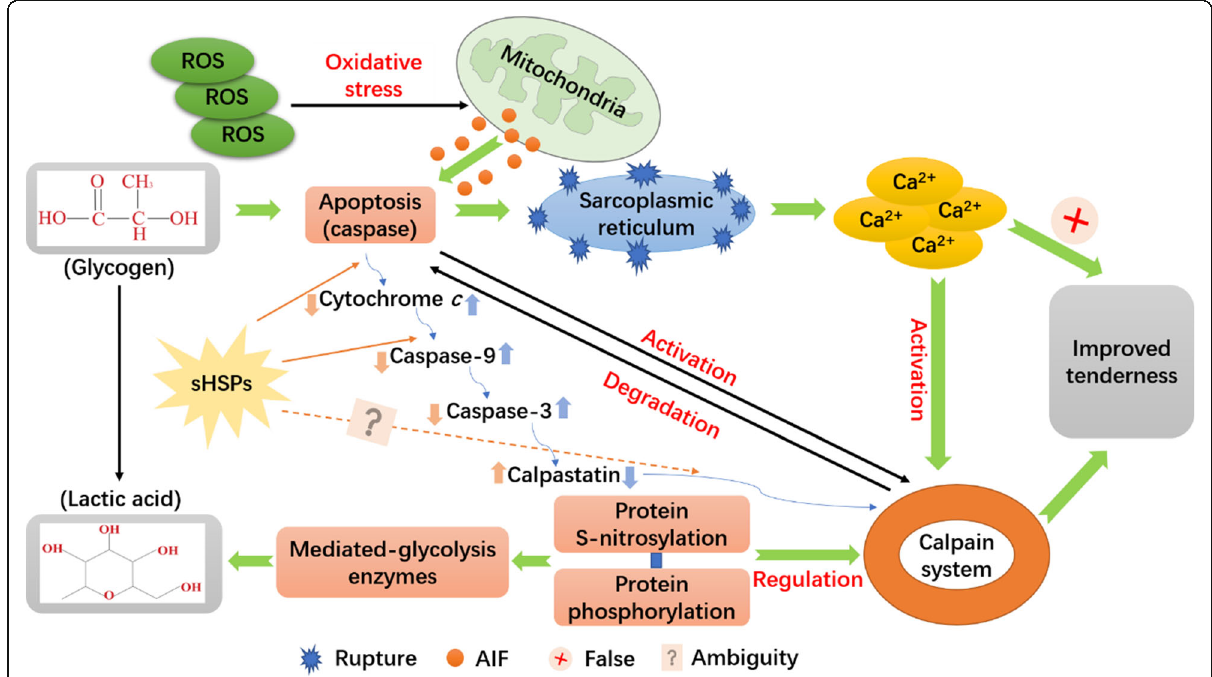
Fig. 1 Multiple mechanisms for postmortem muscle ageing. Note: the dotted line represents ambiguity, and the theory that Ca 2+ directly improves tenderness is usually regarded as a false